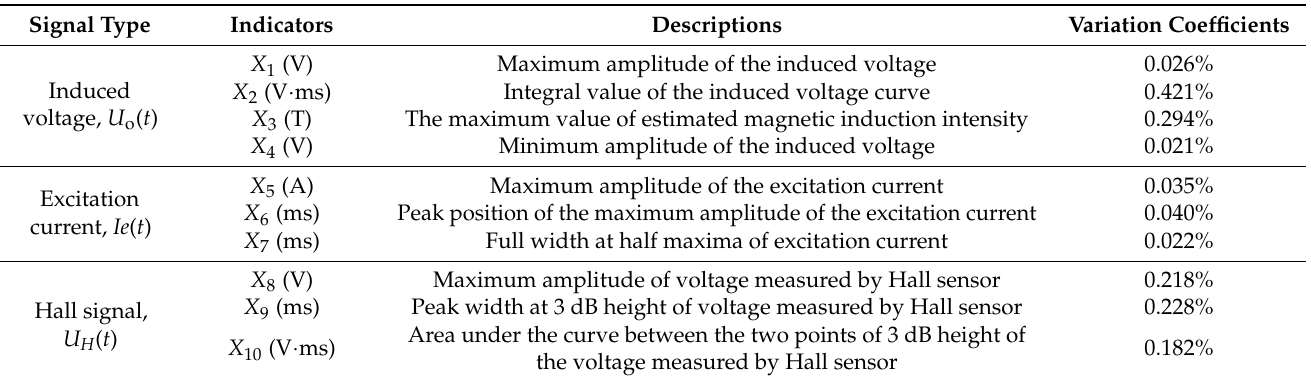
Figure 3. Typical waveforms of measured EM signals. Table 2. Feature parameters extracted from the typically measured EM